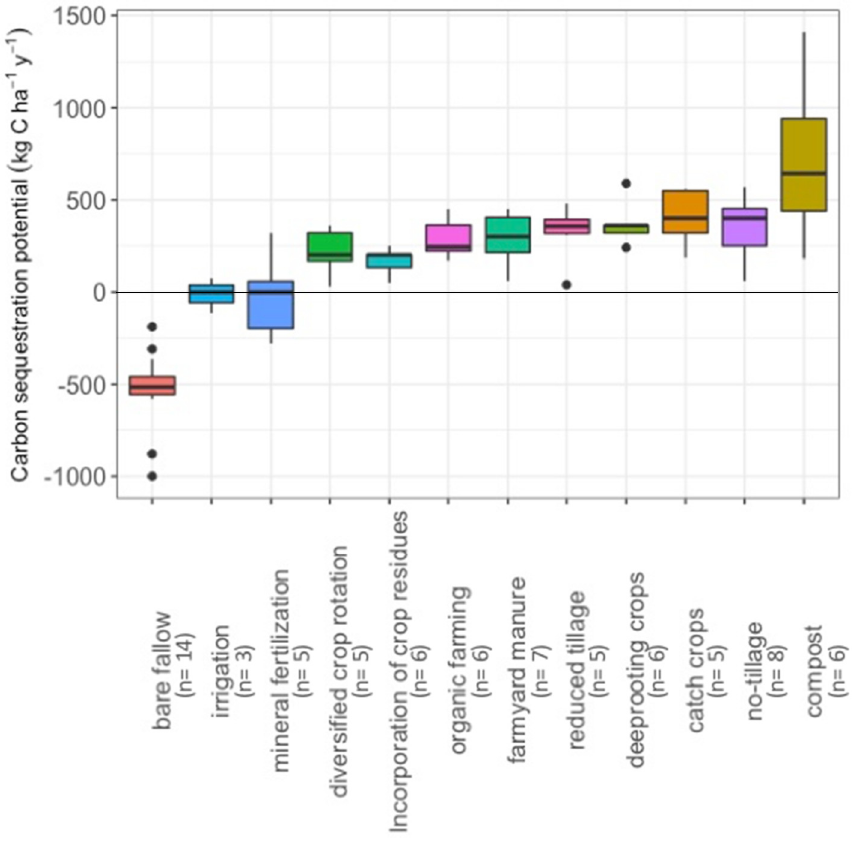
Figure 1. Carbon sequestration potential of agricultural management practices observed in the topsoil (0–20/30 cm) over at least 20 years, in ascending order. Negative C sequestration potential causes net SOC stock losses, while it is the opposite for C sequestration potential > 0. The respective references are given as Supplementary Materials. Each agricultural management practice is assigned a different color. Box- and whiskers diagrams show the median, 5th, 25th, 75th, and 95th percentiles for the carbon sequestration.